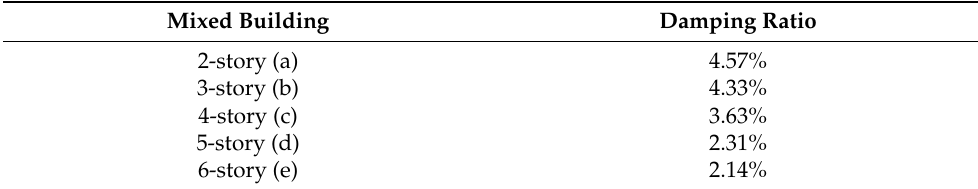
Table 4. Values of uniform damping ratio to be used in NLTH